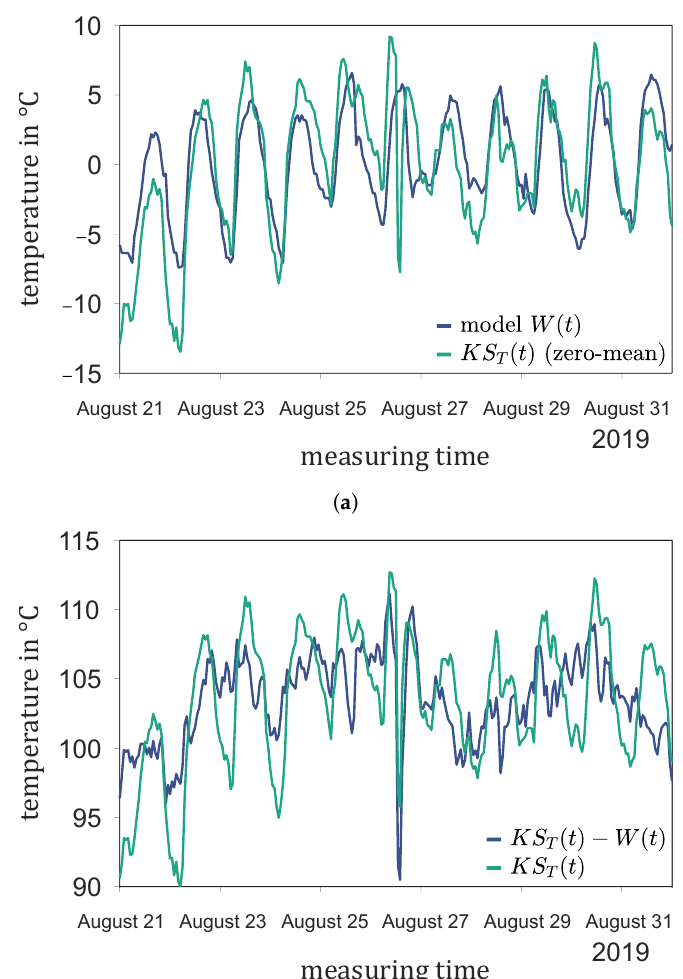
Figure 5. Visualization of ( a ) the weather model data compared to the measured data of the kiln-shell temperature (zero-mean); ( b ) the measured data of the kiln-shell temperatures compared to the kiln-shell temperatures corrected by the weather-related